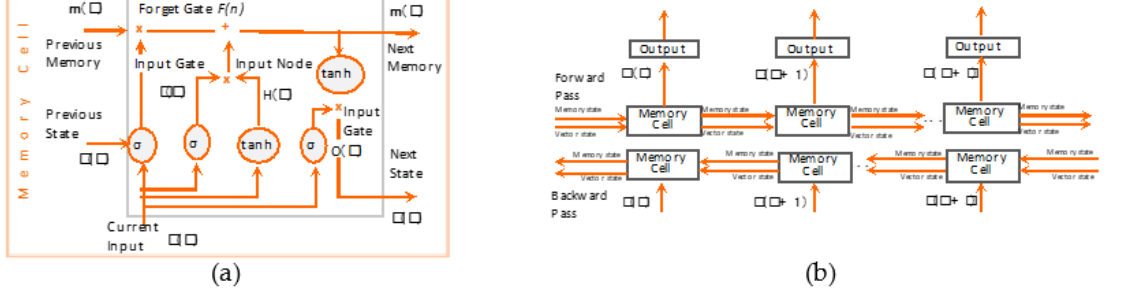
Figure 4. ( a ) The architecture of the memory cell for the Long Short-Term Memory (LSTM) network. ( b ) Bi-directional LSTM unfolded in time.